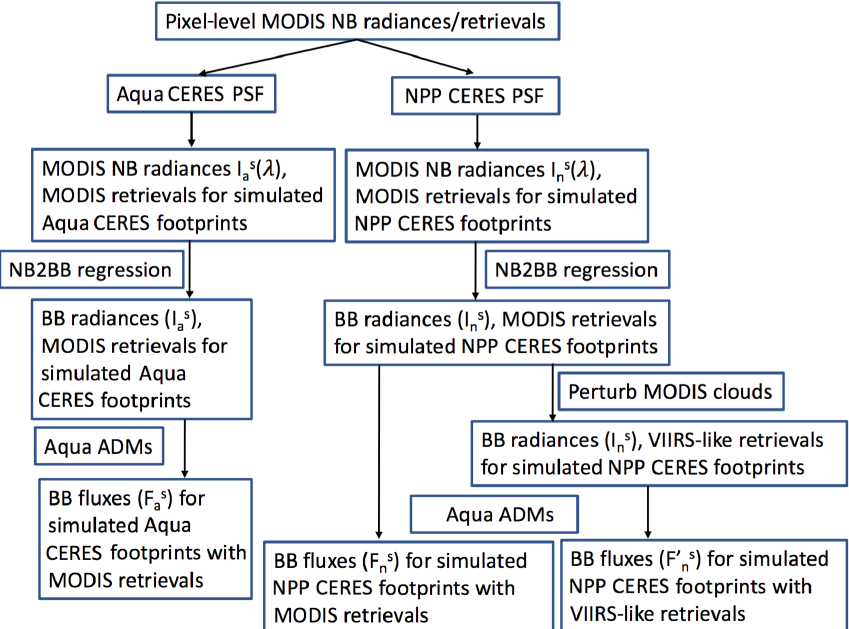
Figure 6. Schematic diagram of convoluting the MODIS pixels into the simulated Aqua and NPP footprints. Left depicts the processes involved in producing the simulated Aqua footprints, middle depicts the simulated NPP footprints with MODIS retrievals, and right depicts the simulated NPP footprints with VIIRS-like